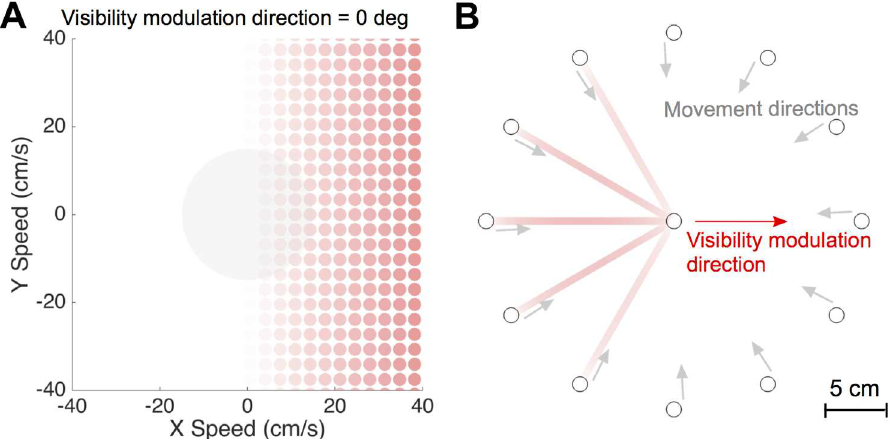
Fig 1. Experimental paradigm and visibility field. (A) Participants made reachingmovement in the horizontal plane with visual feedbackof their hand displayedas a red cursor (they could not see their arm or hand). We imposeda visibilityfield in which the alpha (transparency) of the red hand cursor depended on the hand velocity. In this example,the visibility modulation direction is 0˚ (rightward)and each circle show the appearance of the cursor for that hand velocity. The central grey circle shows the typical range of speedused in the experiment. (B) Cursor appearance for typical straight line movements to the central target for the visibilityfield shown in (A). Note that the actual experiments were performed on a black